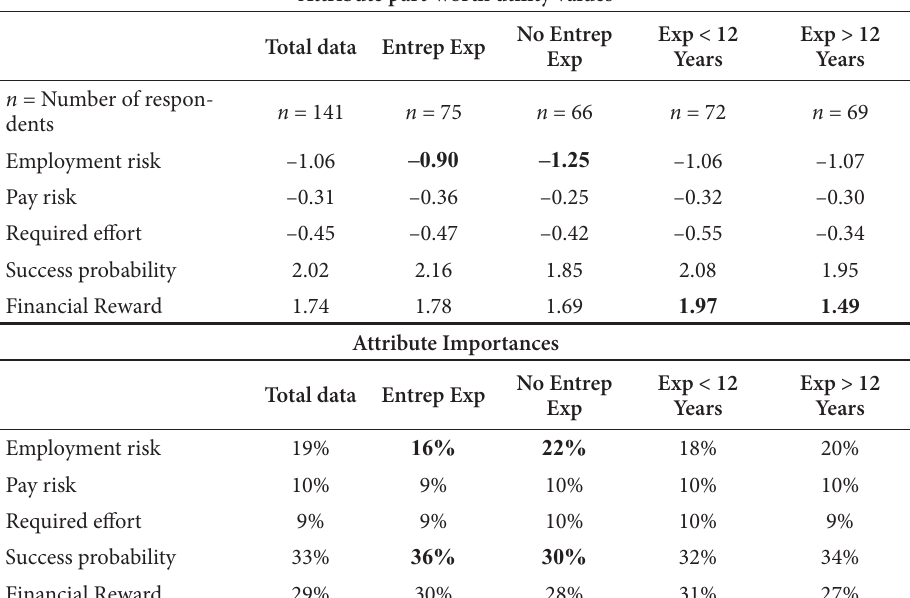
Table 6. Summary of